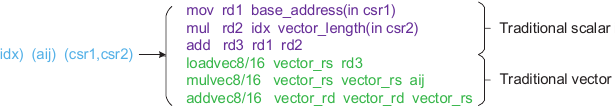
Figure 12. The load-rs-add-rd-vec8/16 instruction for GAT